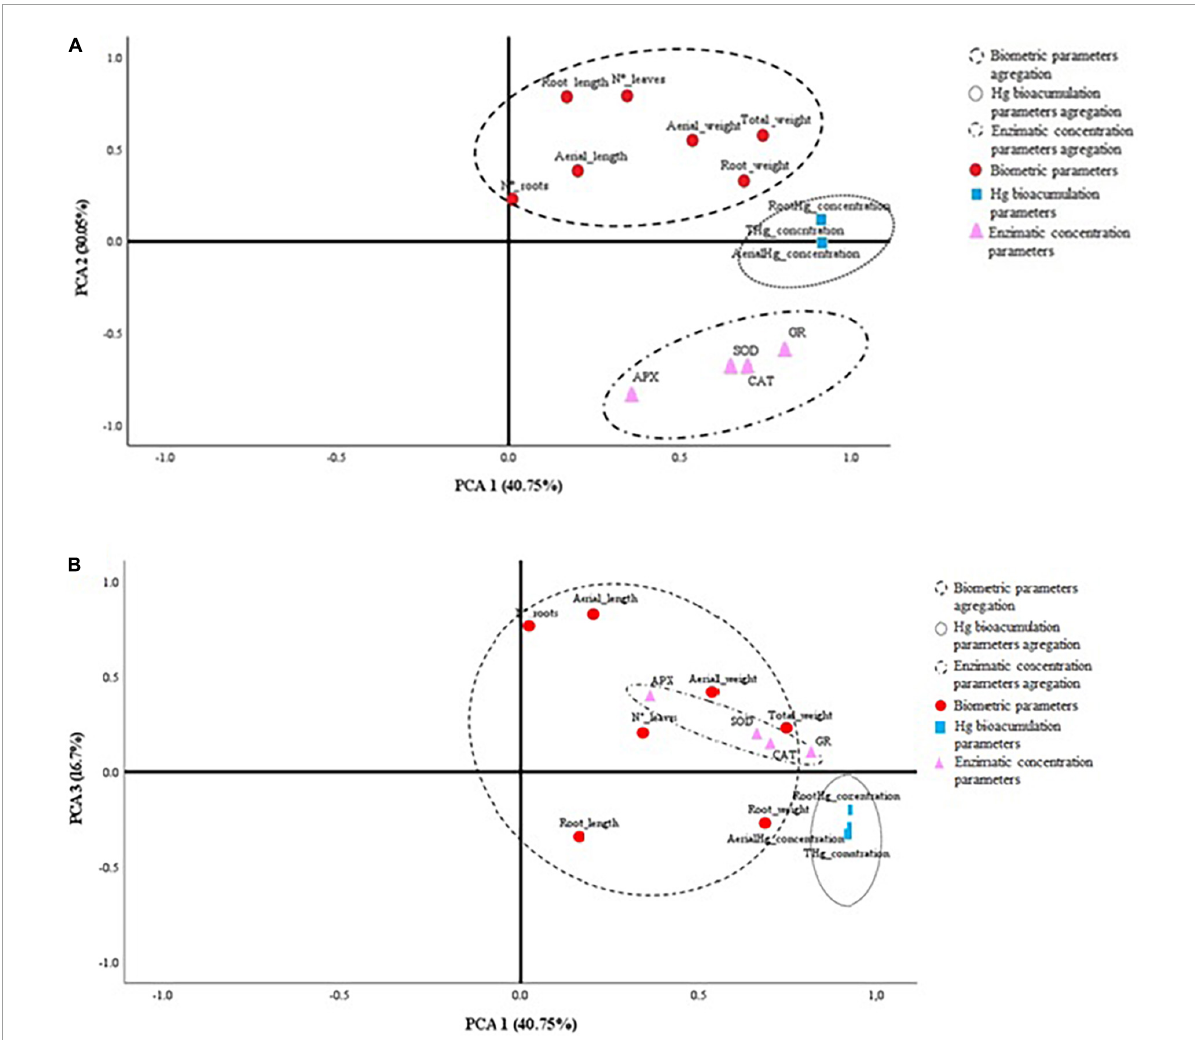
FIGURE3 2D representation of the physiological and biometric variables of the plants according to the load factors of the PCA. (A) PCA1 vs. PCA2; (B) PCA1 vs. PCA3.